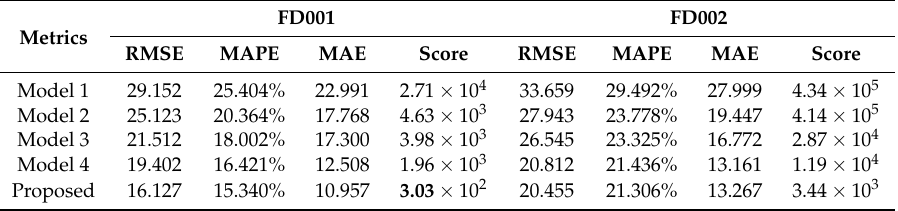
Table 2. Comparison of performance on sub-dataset (FD001) and sub-dataset